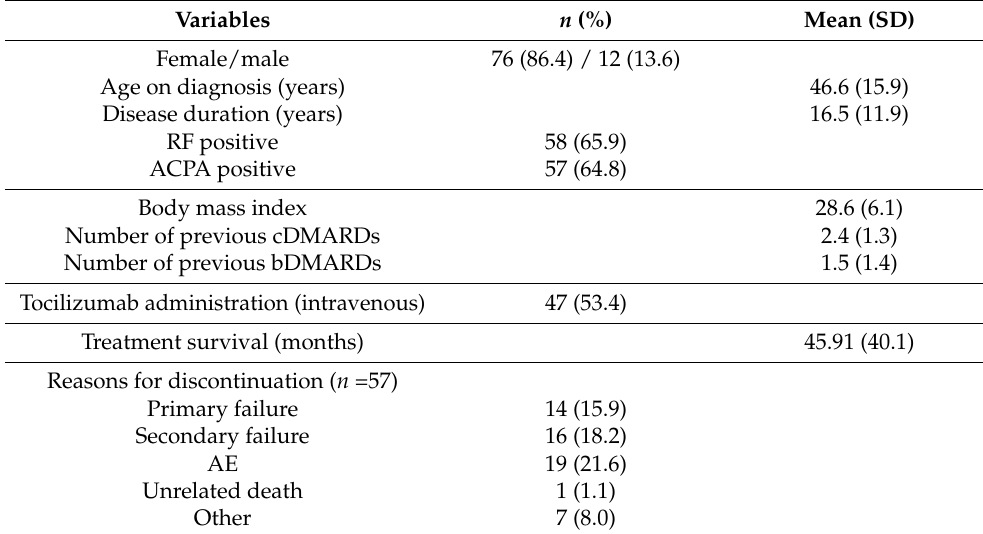
Table 2. Patient baseline characteristics ( n = 88).